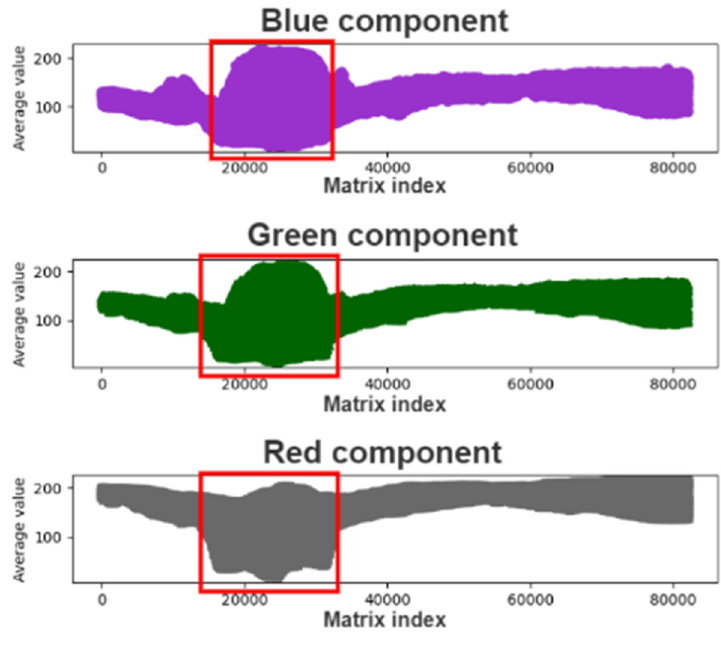
Figure 8. Graph for the average color component matrix.